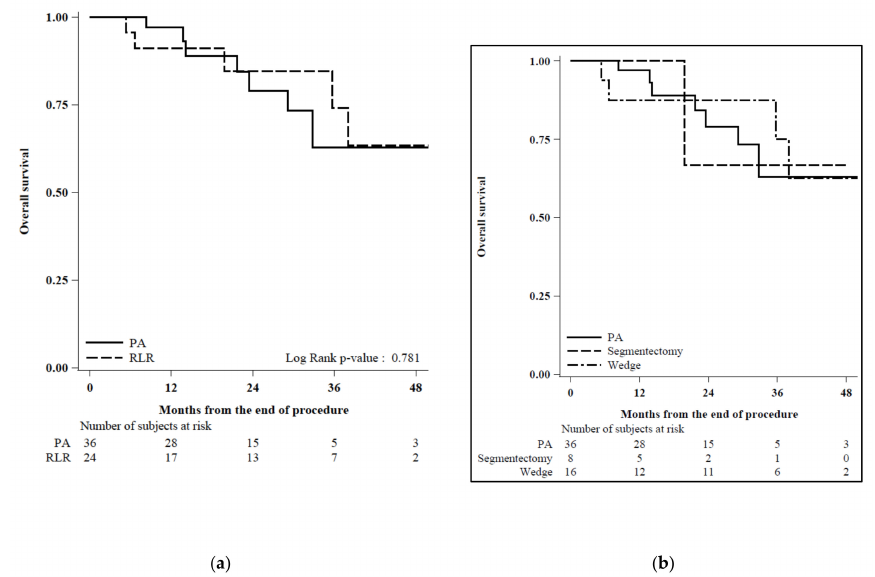
Figure 3. ( a ) Overall survival by procedure (N = 60): Observations were censored at the date of the transplant. Cause of deaths: N = 4 “HCC” and N = 3 “Others” in PA and N = 3 “HCC” and N = 2 “Others” in RLR. ( b ) Cause of deaths: N = 4 “HCC” and N = 3 “Others” in PA, N = 1 “Others” in Segmentectomy, N = 3 “HCC”, and N = 1 “Others” in